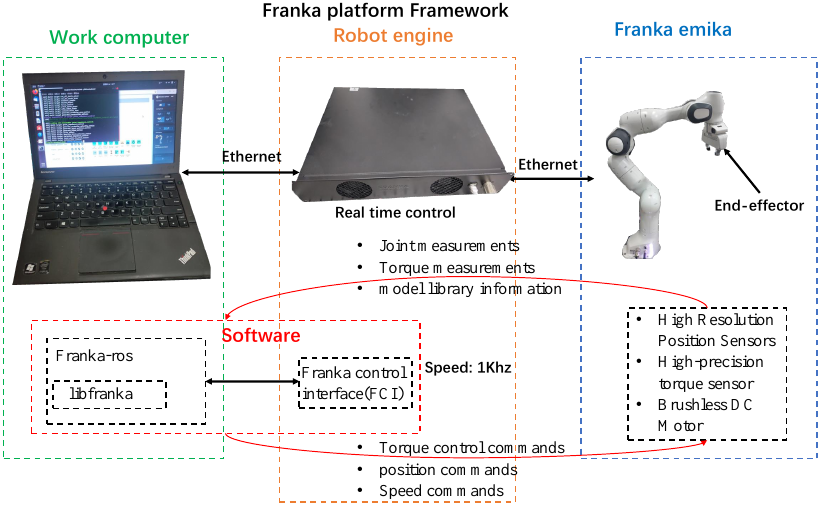
Figure 6. Franka emika Collaborative Robotics Platform